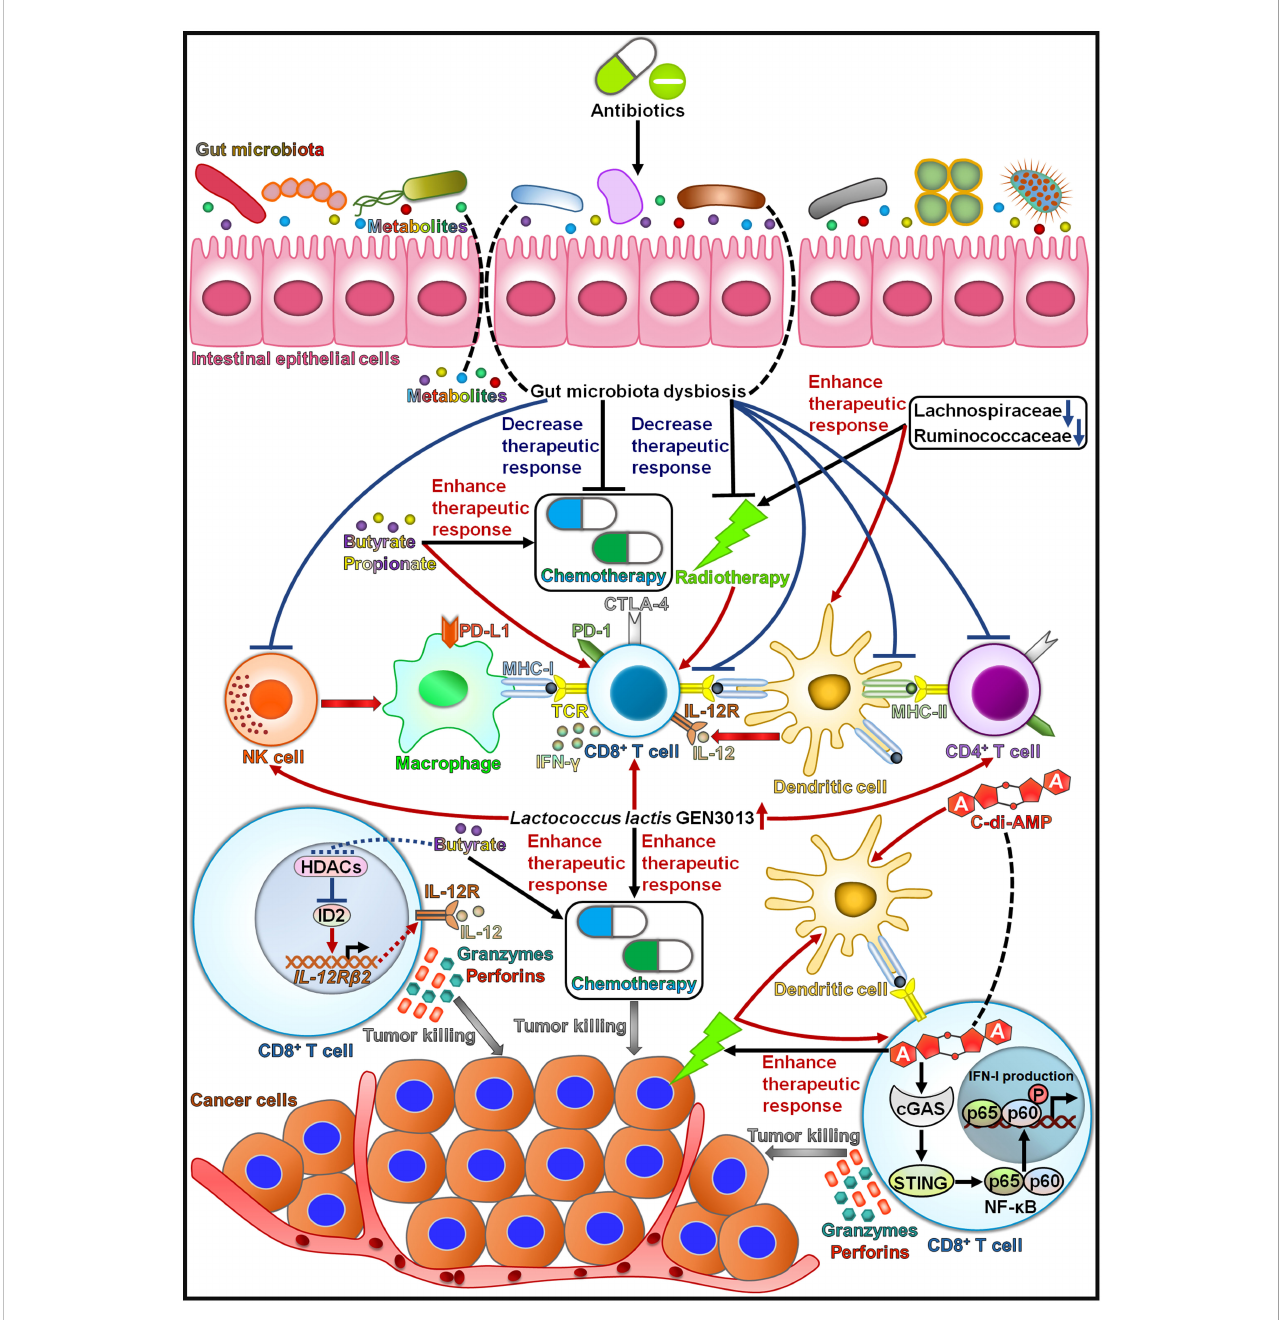
FIGURE 3 The impact of the gut microbiota on the responses to cancer chemotherapy and radiotherapy. Antibiotic-induced intestinal dysbiosis contributes to decreased therapeutic response to anticancer agents through inhibition of immune cells including NK cells, dendritic cells and CD4 + T cells. Depletion of Lachnospiraceae and Ruminococcaceae potentiates the anticancer ef fi cacy of radiotherapy by enhancing antigen presentation and CD8 + T cell activity. Gut microbial metabolites butyrate and propionate enhance the anticancer activity of oxaliplatin by inducing CD8 + T cell responses. Butyrate can downregulate HDACs to increase ID2 expression, leading to the activation of IL-12 signaling pathway. These events cause the reinforcement of CD8 + T cell function and improvement of chemotherapeutic ef fi cacy. Lactococcus lactis GEN3013 increases the effectiveness of conventional chemotherapy by promoting the accumulation of NK cells, CD4 + T cells and CD8 + T cells. Gut microbiota dysbiosis suppresses the activation of T cells induced by radiotherapy, hence restricting the responsiveness to radiotherapy. C-di-AMP synergizes with radiotherapy to facilitate the maturation and presentation functions of DCs, enhancing IFN- b production and CD8 + T cell activation via the cGAS/STING signaling cascade. NK cell, natural killer cell; PD-L1, programmed death-ligand 1; MHC-I, major histocompatibility complex class I; IFN- g , interferon- g ; TCR, T cell receptor; PD-1, programmed death-1; CTLA-4, cytotoxic T lymphocyte-associated antigen-4; IL-12, interleukin-12; IL-12R, interleukin-12 receptor; MHC-II, major histocompatibility complex class II; HDACs, histone deacetylases; ID2, Inhibitor of DNA binding 2; IL-12R b 2, interleukin-12 receptor b 2; c-di-AMP, cyclic di-adenosine monophosphate; cGAS, cyclic GMP-AMP synthase; STING, stimulator of interferon genes; NF- k B, nuclear factor- k